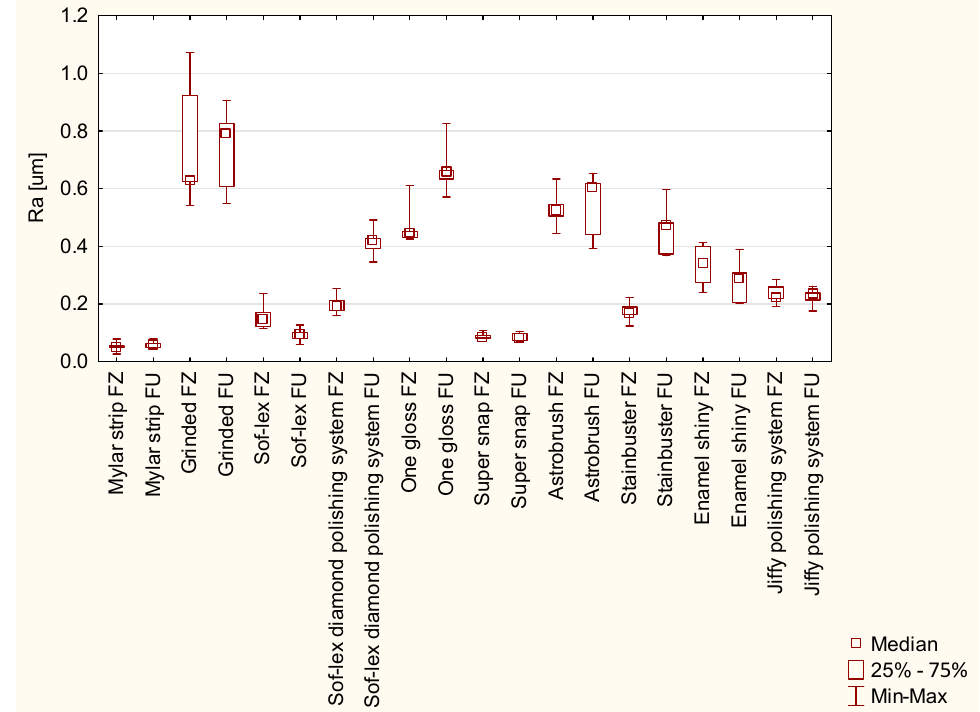
Figure 1. Median analysis, Ra comparison between FU and FZ. The lowest Rlr values are obtained after polishing the samples with the Enamel Shiny for FU (1.000), and with the Sof-Lex, the Sof-Lex Diamond Polishing System, and Jiffy Polishing Kit for FZ (1.001) [Tables 5 and 6, Figure 2]. The value is only slightly higher after polishing both materials with Super Snap (1.001 for FU and 1.002 for FZ). Table 5. Descriptive statistics, Rlr for Filtek Ultimate.